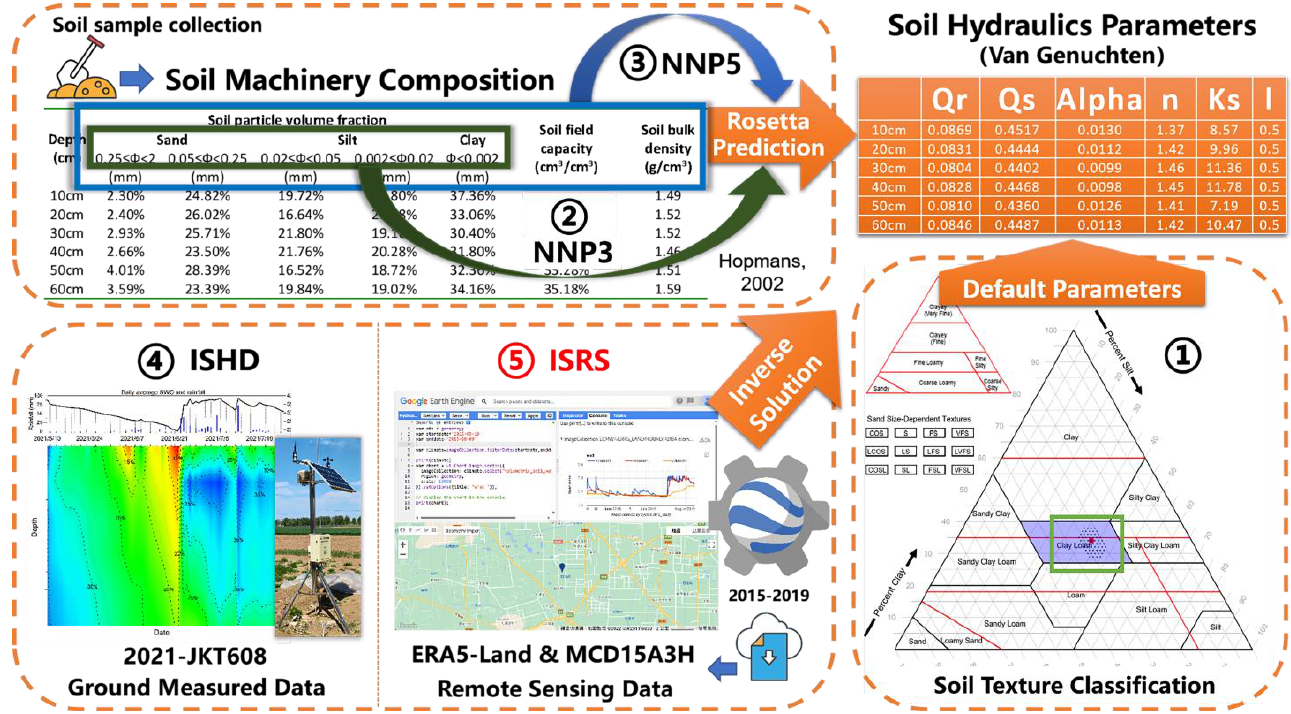
Figure 3. Different methods for obtaining soil hydraulic parameters for the Hydrus-1D model. Table 2. Mechanical composition of the soil at different depths.